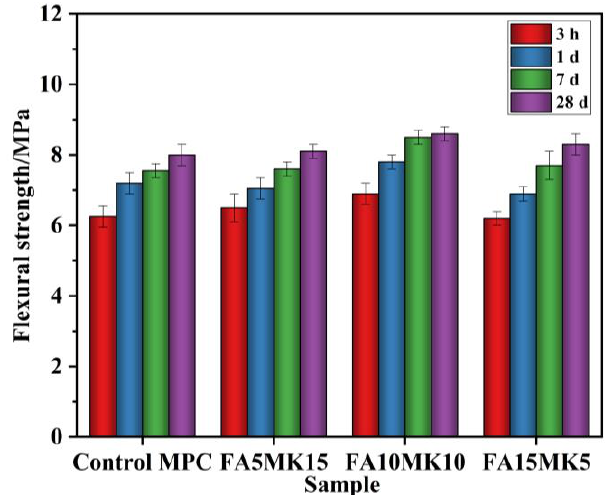
Figure 16. MPC flexural strength with addition of compound powder.